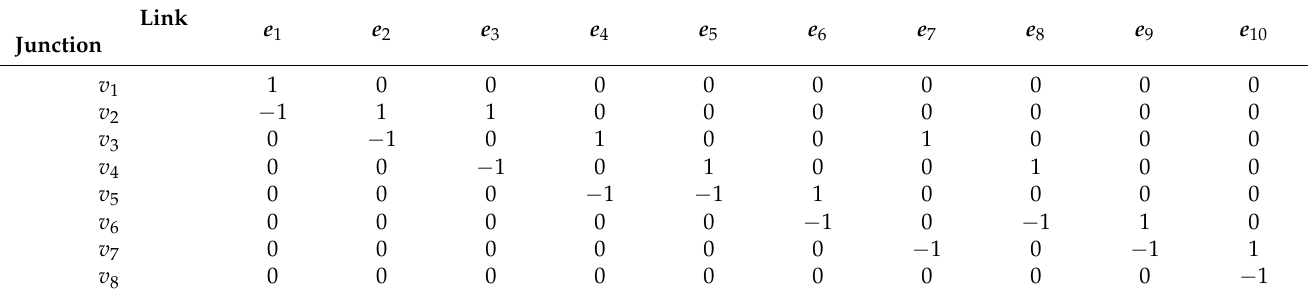
Table 2. The complete incidence matrix (corresponding to Figure 5).